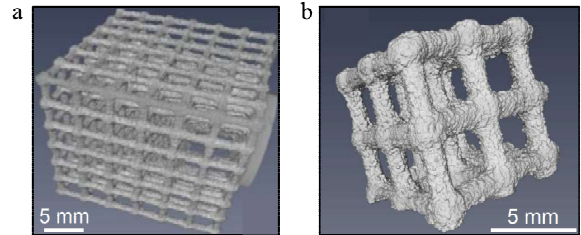
Fig. 15 Micro-CT images of SiC ceramic: (a) BJ combined with PIP; (b) BJ combined with CVI and CVD. Reproduced with permission from Ref. [57], © Elsevier